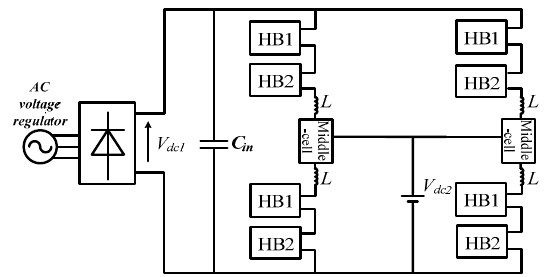
Figure 14. Power circuit of the proposed DC-DC MMC.